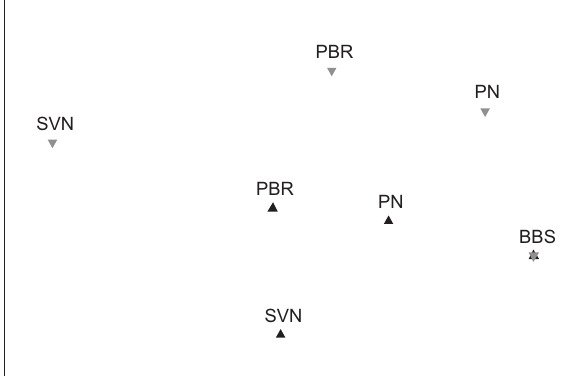
Figure 2. NMDS ordination of isopod species composition in more disturbed (grey inverted triangles) and less disturbed (black tri- angles) sites in each protected area. (BBS) Boracéia Biological Sta- tion, (PBR) Paranapiacaba Biological Reserve, (PN) Parque das Neblinas, (SVN) Santa Virgínia nucleus.